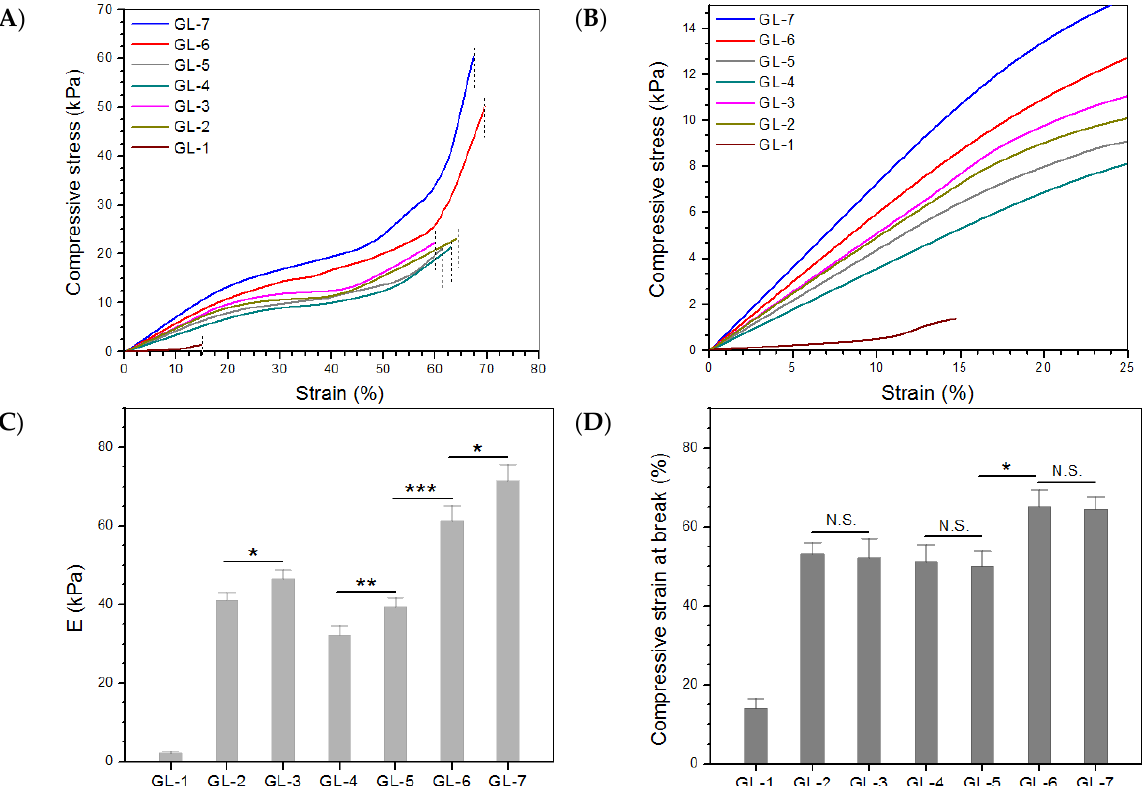
Figure 4. Representative strain-stress curves ( A ), dash lines denote the compressive strain at the break), enlarged view of strain-stress curves in low strain region ( B ), average compressive modulus ( C ) and compressive strain at the break ( D ) for different gels (***, p < 0.001; **, p < 0.01; *, p < 0.05; N.S., no significance).